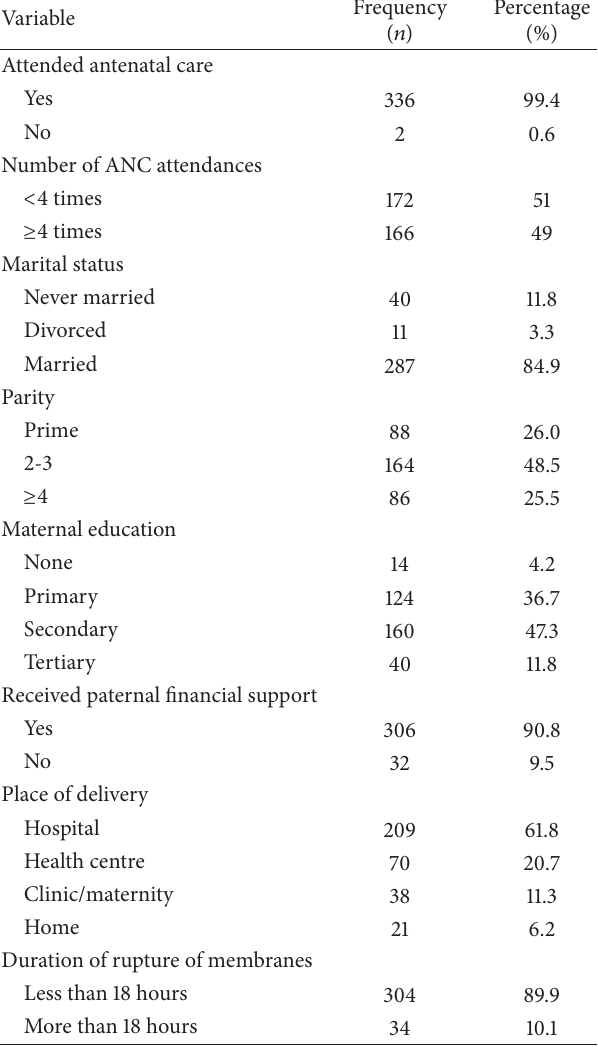
Table 1: Characteristics of 338 mothers in Kampala District, Uganda,